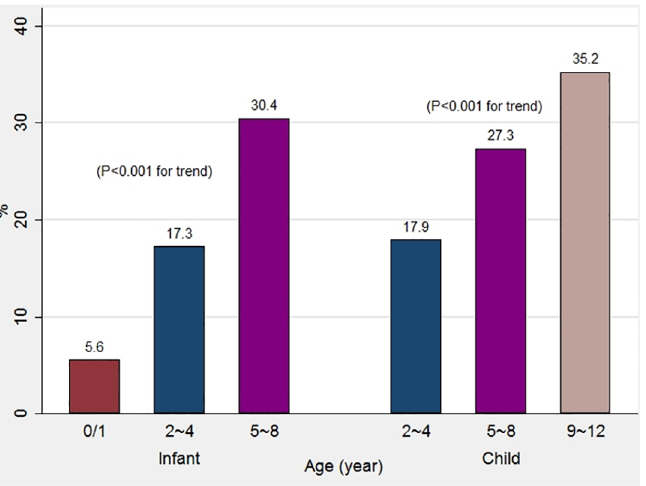
Fig 2. Percentage of children having a GP visit free year in different age periods, by